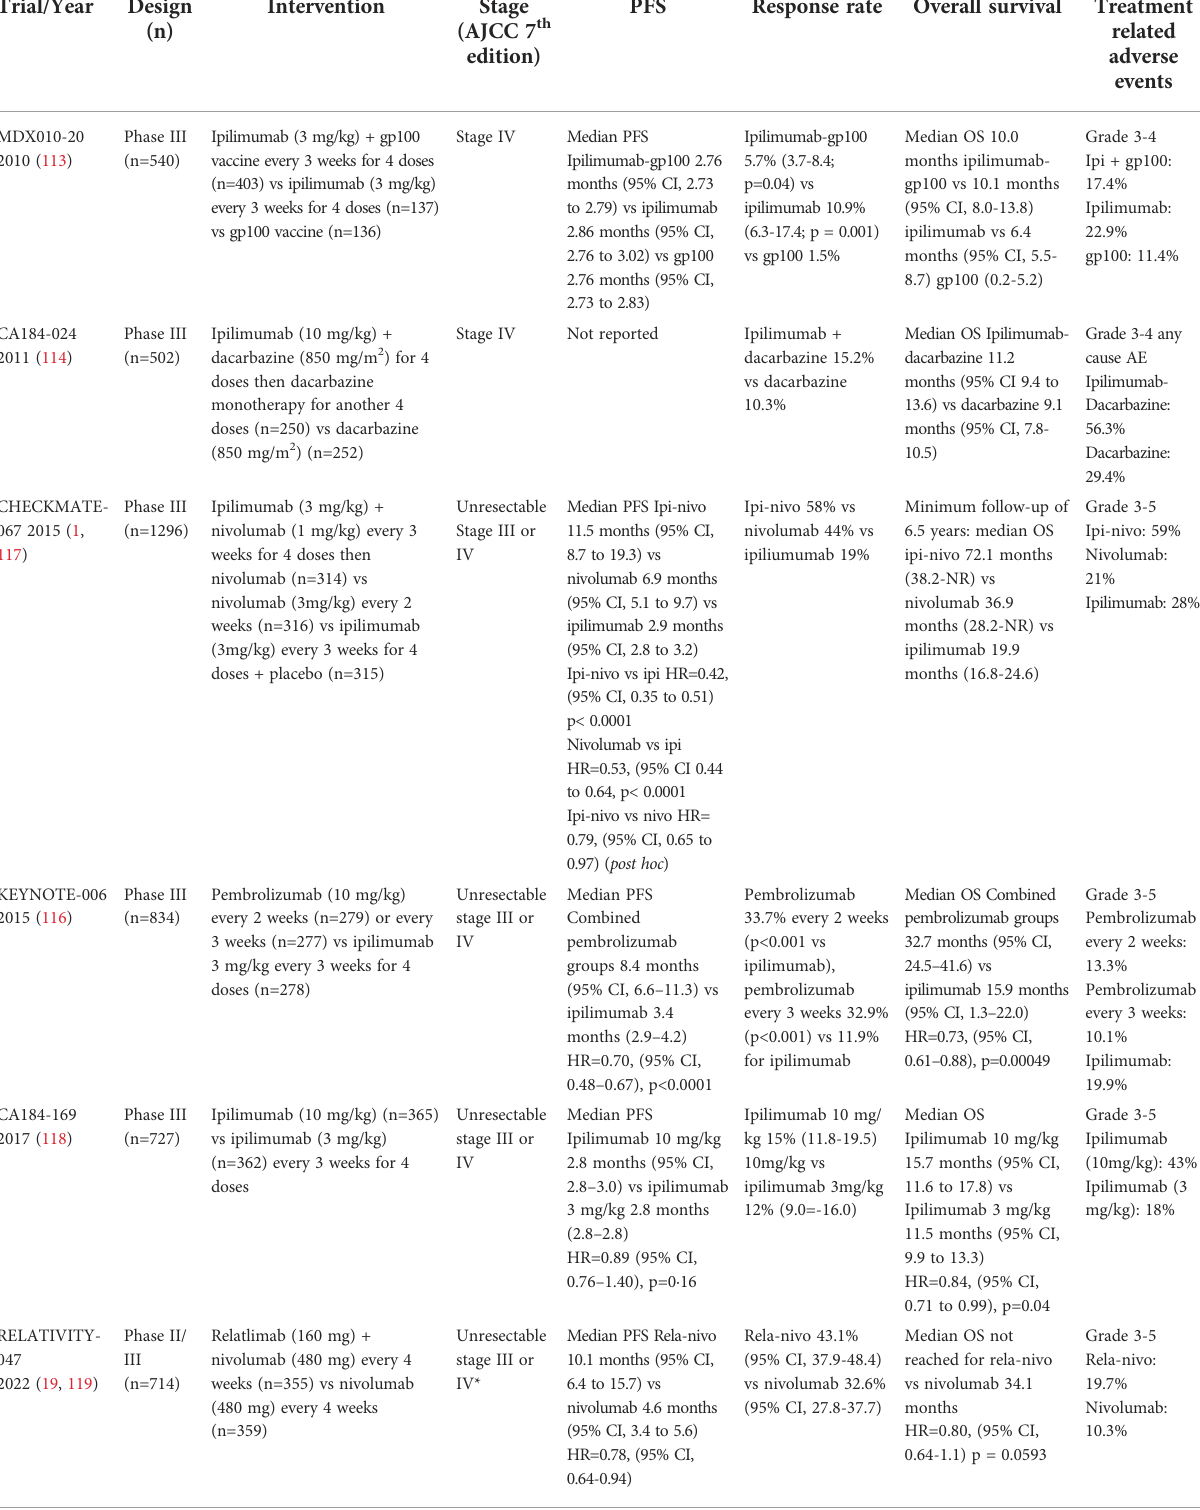
TABLE 1 Key clinical trials in metastatic/unresectable melanoma.